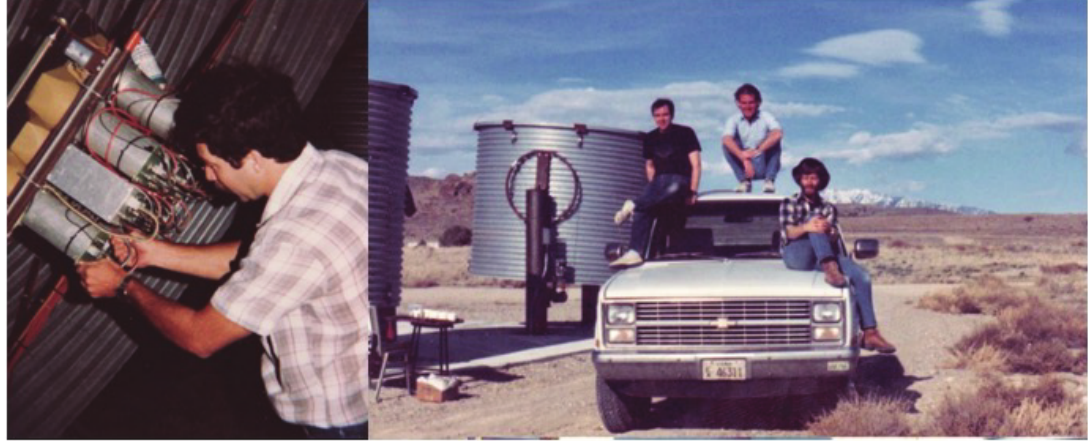
Figure 5. P. Gerhardy checking a phototube base.(L); B. Fick, B.Dawson, D. Liebing on 5 Mile Hill, the FE 1 site. One of the many 4w drive vehicles used up over the course of the experiment to access 5 Mile Hill, the F.E. 1